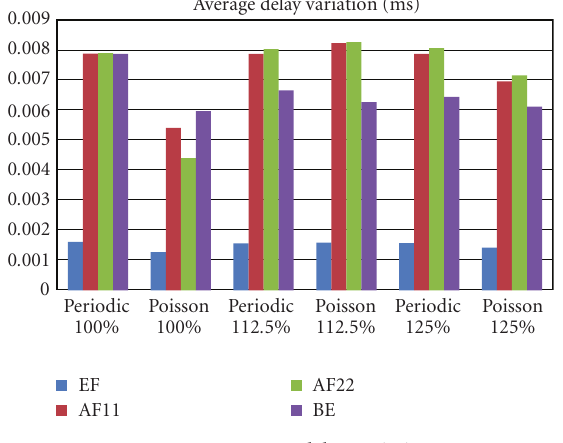
Figure 15: Average delay variation.